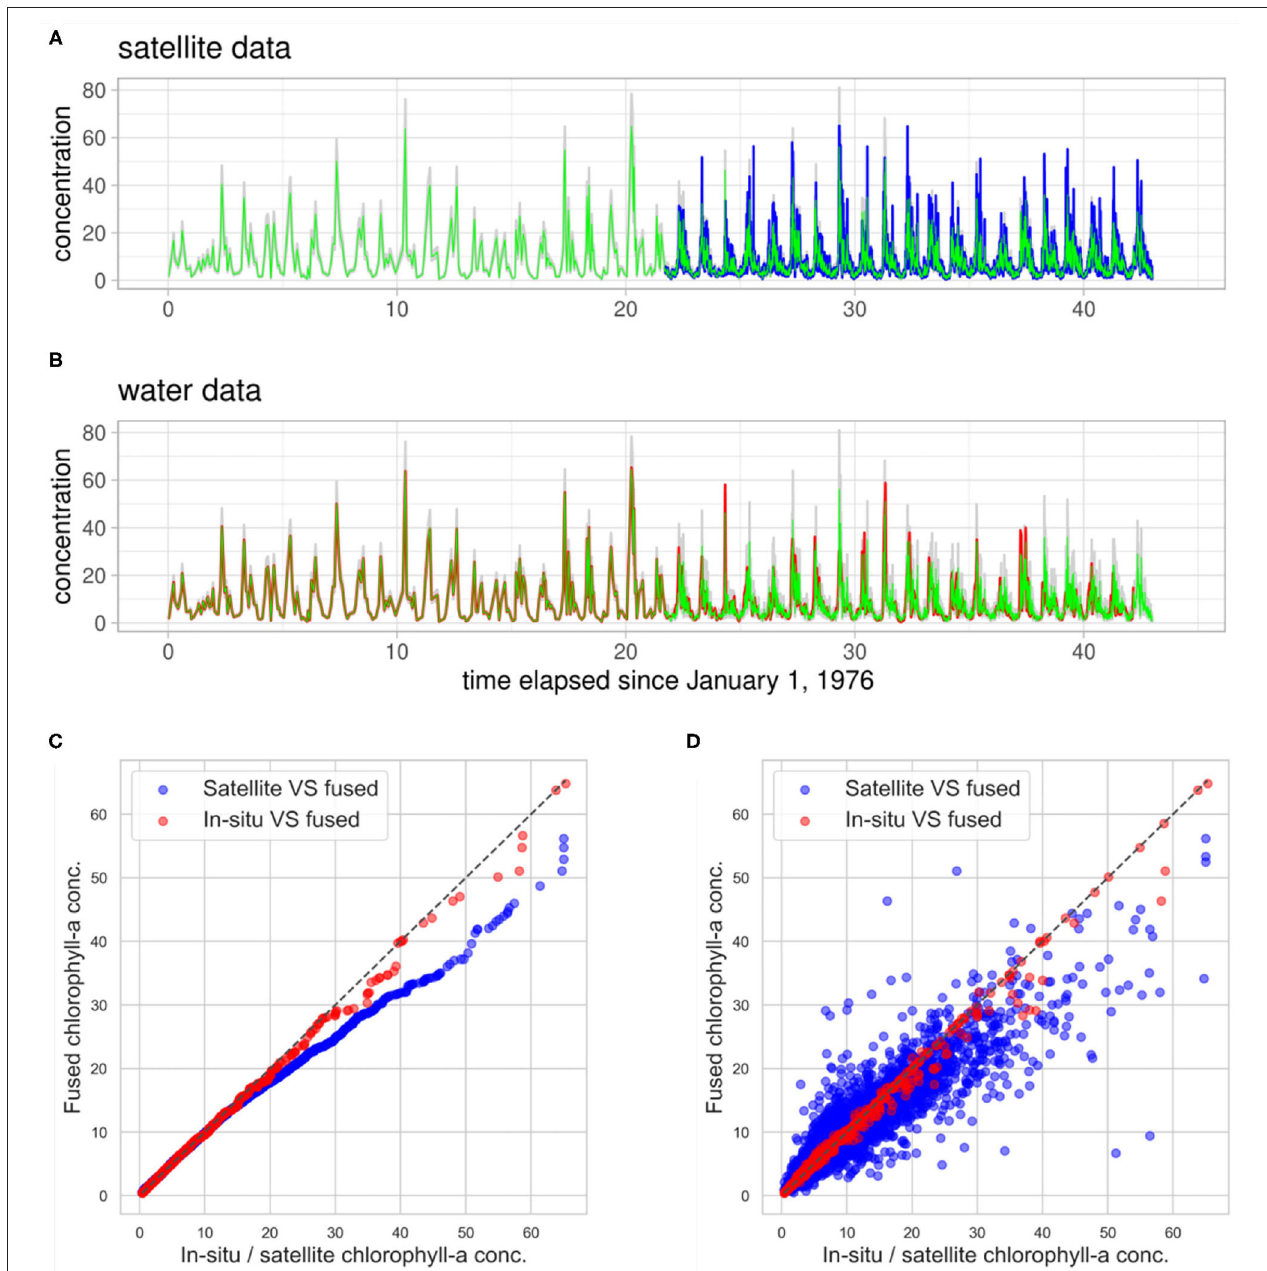
FIGURE 8 | Data fusion results. The mean fused chlorophyll-a concentration signal (green) with uncertainty (gray) compared with satellite observations (blue) in (A) , and in-situ “water” observations (red) in (B) . Quantile-quantile plot of the fused signal compared to both in-situ and satellite observations in (C) and scatter plot in (D)